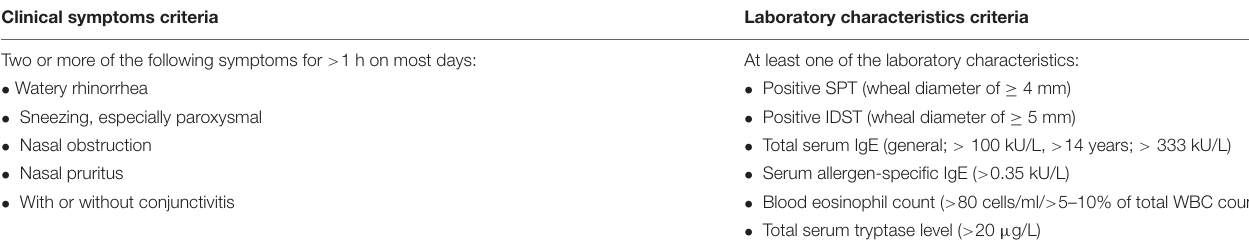
TABLE 1 | Diagnosis criteria of allergic rhinitis (AR) based on clinical symptoms and laboratory characteristics criteria (9). Clinical symptoms criteria Laboratory characteristics